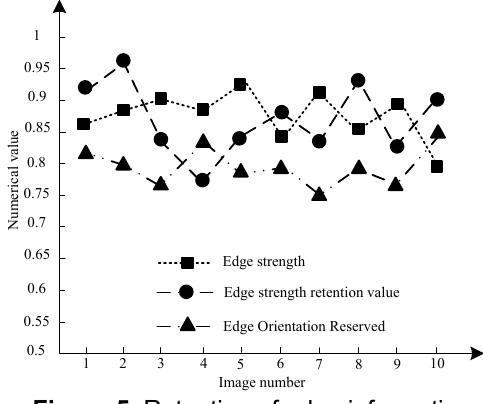
Figure 5. Retention of edge